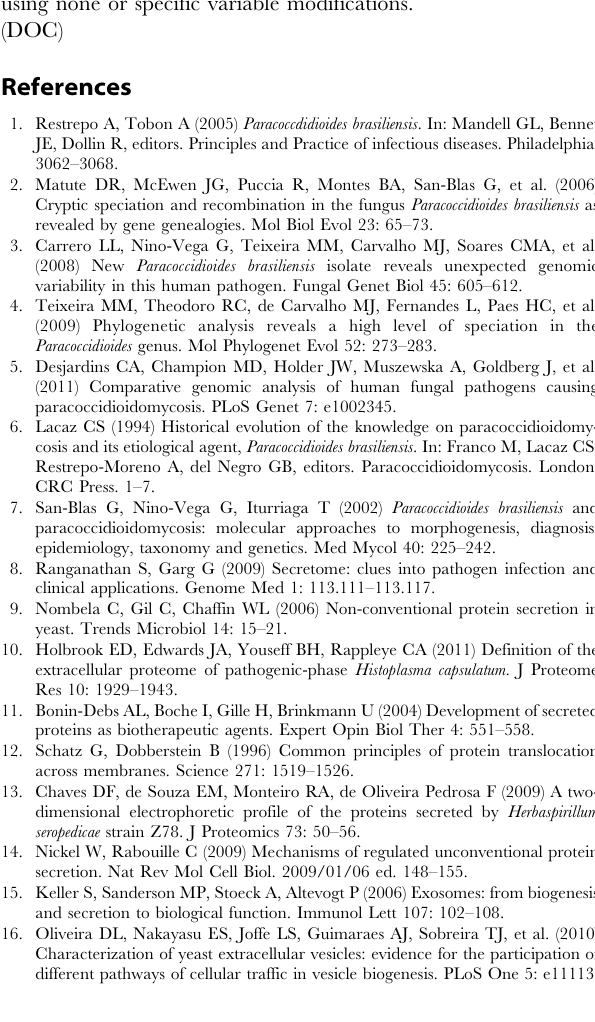
Table S2 Exclusive proteins secreted by Paracoccidioi- des Pb 01 yeast and mycelia. 1 Spots numbers indicated in Figure 2. 2 NCBI database general information number (http:// www.ncbi.nlm.nih.gov/). 3 Number of identified isoforms of protein in each Paracoccidioides, Pb 01 phase secretome. 4 The average of amount of values of abundances of all identified isoforms. 5 Protein Expression in M: mycelia phase; Y: Yeast phase. 6 Secretion prediction according to Signal P 3.0 server, the number corresponds to signal peptide probability (http://www.